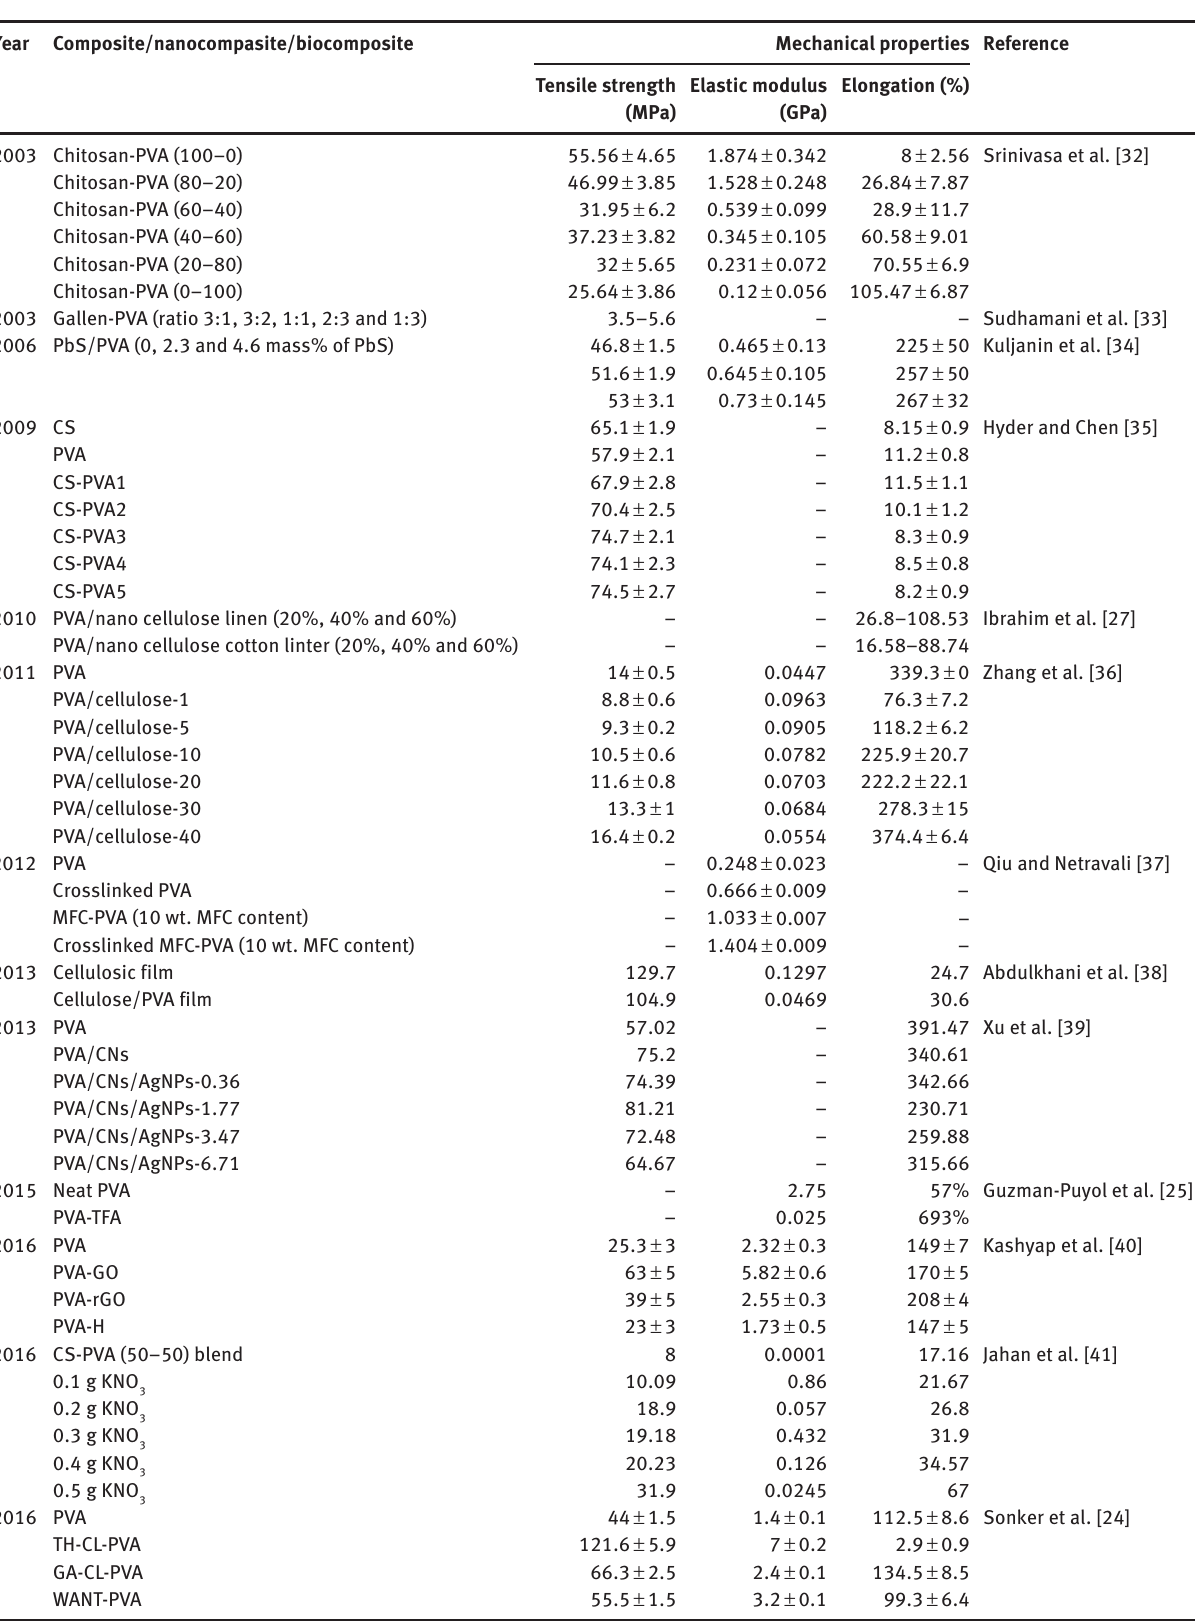
Table 2: Mechanical properties of PVA based